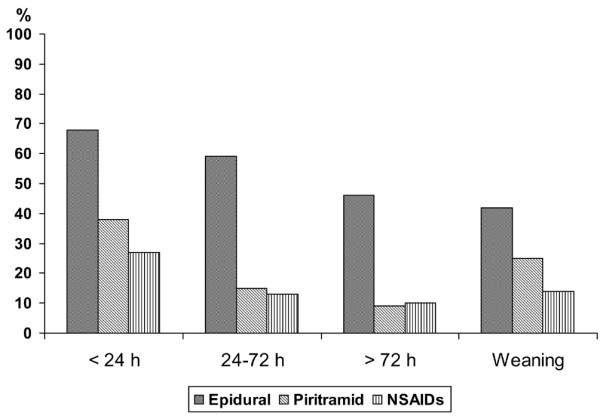
Epidural analgesia, piritramid and NSAIDs in the different phases of analgesia and sedation. The values were tested with the χ2 test (P < 0.05) and multiple differences with the Bonferroni–Holm multiple test procedure. NSAIDs, non-steroidal anti-inflammatory drugs. (Epidural: less than 24 hours versus more than 72 hours; less than 24 hours versus weaning; 24–72 hours versus more than 72 hours and 24–72 hours versus weaning, all P < 0.01; less than 24 hours versus 24–72 hours, P = 0.015; more than 72 hours versus weaning, P = 0.37. Piritramid: less than 24 hours versus 24–72 hours versus more than 72 hours versus weaning, all P < 0.01. NSAIDs: less than 24 hours versus 24–72 hours, less than 24 hours versus more than 72 hours and less than 24 hours versus weaning, all P < 0.0001; 24–72 hours versus more than 72 hours, P = 0.14; 24–72 hours versus weaning, P = 0.67; more than 72 hours versus weaning, P = 0.087.)